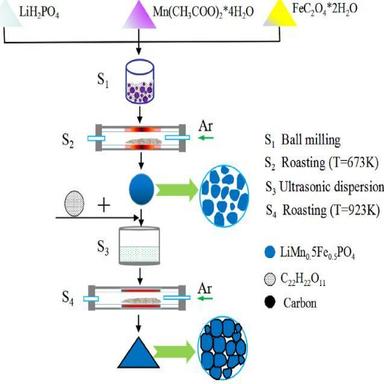
Material preparation process.